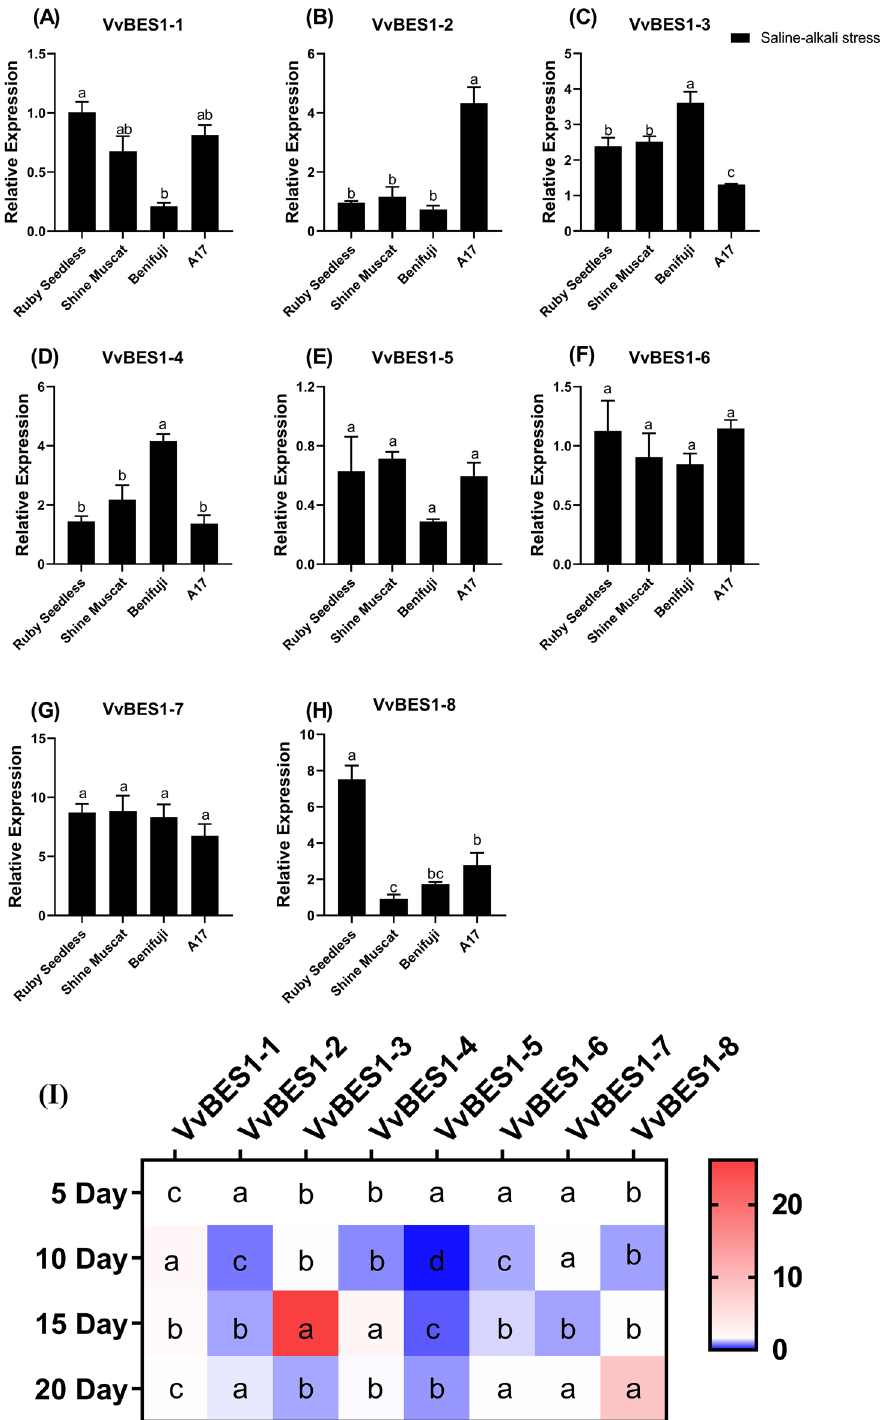
Figure 8. ( A–H ) The expression profiles of the VvBES1 gene in different V. vinifera varieties in response to saline–alkali stress; the error bars represent ± SE (n = 3), and the relative expression changes are relative to the control group (VvBES1-1 of Ruby seedless), which are represented as log 2 fold change. The one-way Duncan’s new multiple-range test was implemented to assess the significance of differences among treatments (p < 0.05), asterisk indicates differences between data, while double asterisk indicates significant differences between data. ( I ) The expression profiles of VvBES1 gene under saline–alkali stress in “Muscat Hamburger” V. vinifera leaves; the error bars represent ± SE (n = 3), and the relative expression changes are relative to the VvBES1-1 at 5 days after treatment, which are represented as log 2 fold change. The one-way Duncan’s new multiple-range test was implemented to assess the significance of differences among treatments (p <